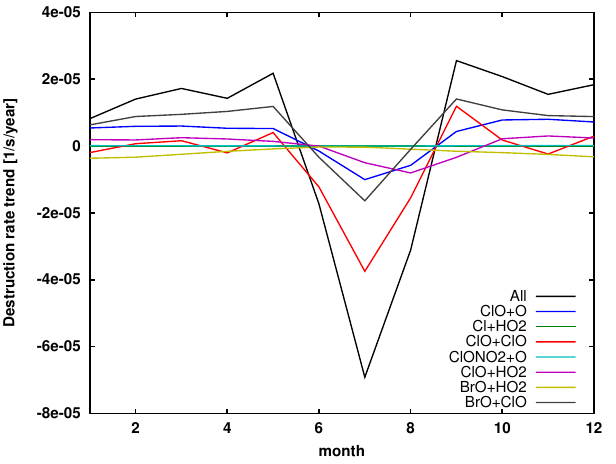
Fig. 14. Trend coefficients from NIWA-SOCOL of the destruction rates by the Cl y cycles averaged over 45 to 60 ◦ S at 70hPa of the sum of all reaction cycles (black line) and individual cycles (in color, as indicated by the legend).